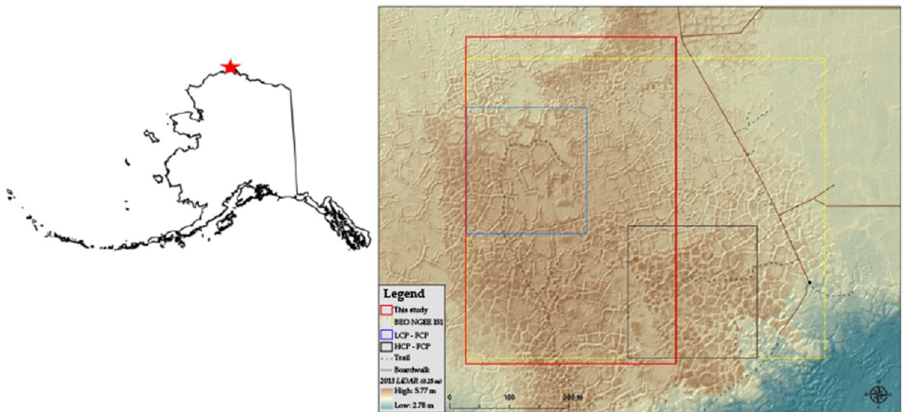
Figure 1. Map of the Barrow Environmental Observatory (BEO) polygonal tundra with LiDAR relief shading. Lefthand image shows the location of the BEO (red star) within AK, USA. A large dashed yellow box defines the broader BEO study site with the small blue box highlighting a predominantly low-centered polygon and flat-centered polygon region and the black box highlighting a predominately high-centered polygon and flat-centered polygon region. The red rectangle indicates the spatial extent of the nitrate inventory domain for this specific study, which is 0.191 km 2 .